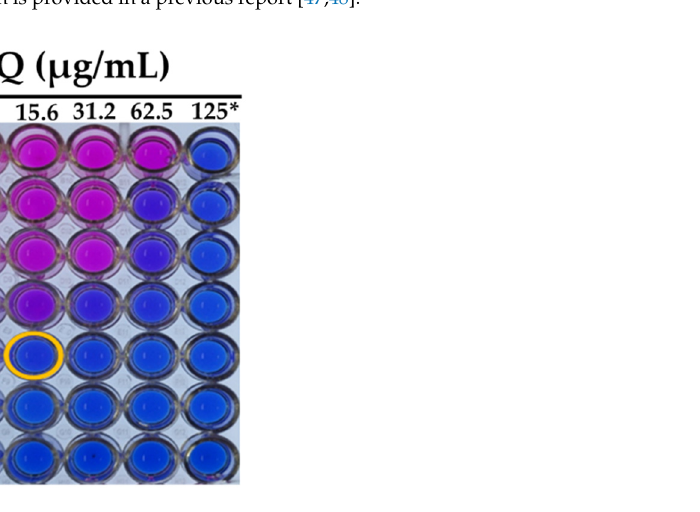
Figure 6. Checkerboard analysis of CuO NPs and AQ against ATCC 25923 with resazurin dye. The 96-well plate was imaged with a digital camera (Samsung NX200). The asterisk represents MIC, and the orange circle indicates the position FICI = 0.375.